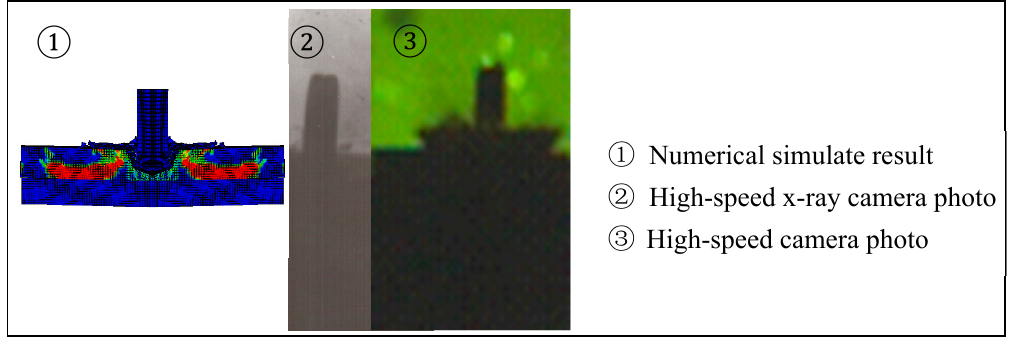
Figure 1. Comparison of the numerical simulation and test results of the projectile penetration